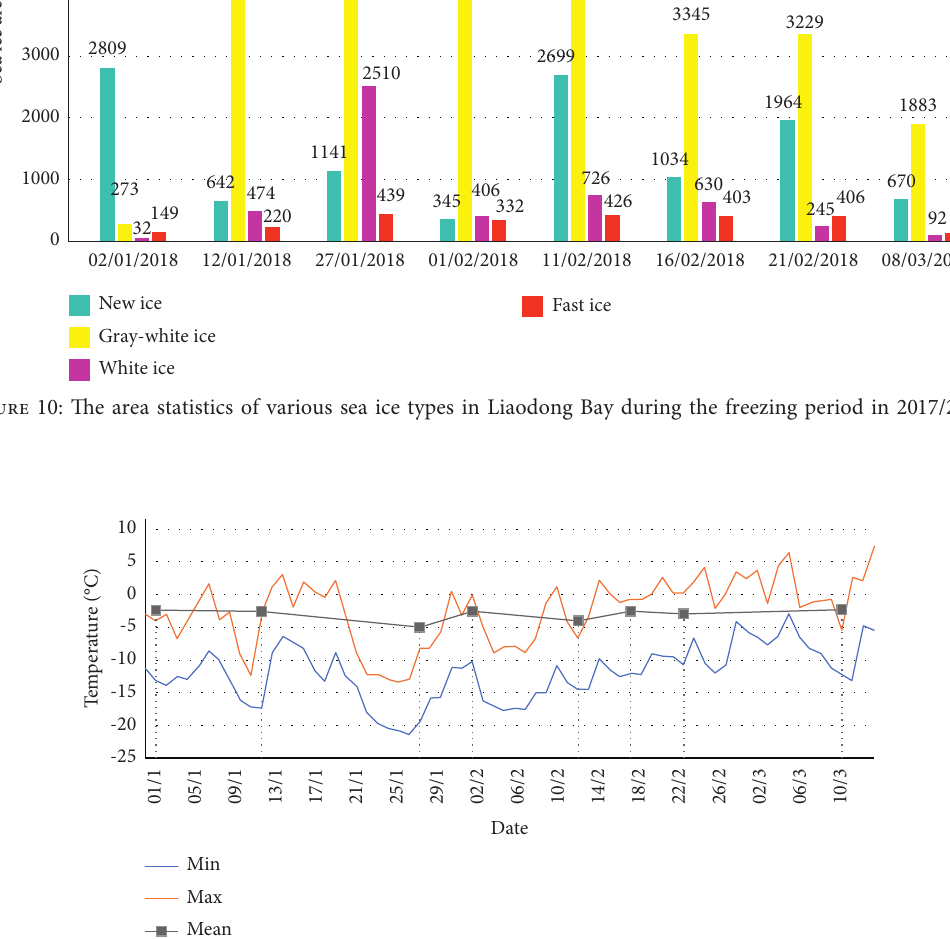
Figure 11: Trend of temperature in Liaodong Bay during the freezing period in 2017/2018. The mean near-surface temperatures were derived from the MODIS data. The maximum and minimum temperatures were obtained according to the weather forecast information issued by China Meteorological Administration. The vertical dashed lines represent the acquisition times which the Sentinel-2 images